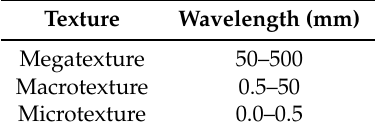
Table 2. Dimensional range of defined textures for a surface.